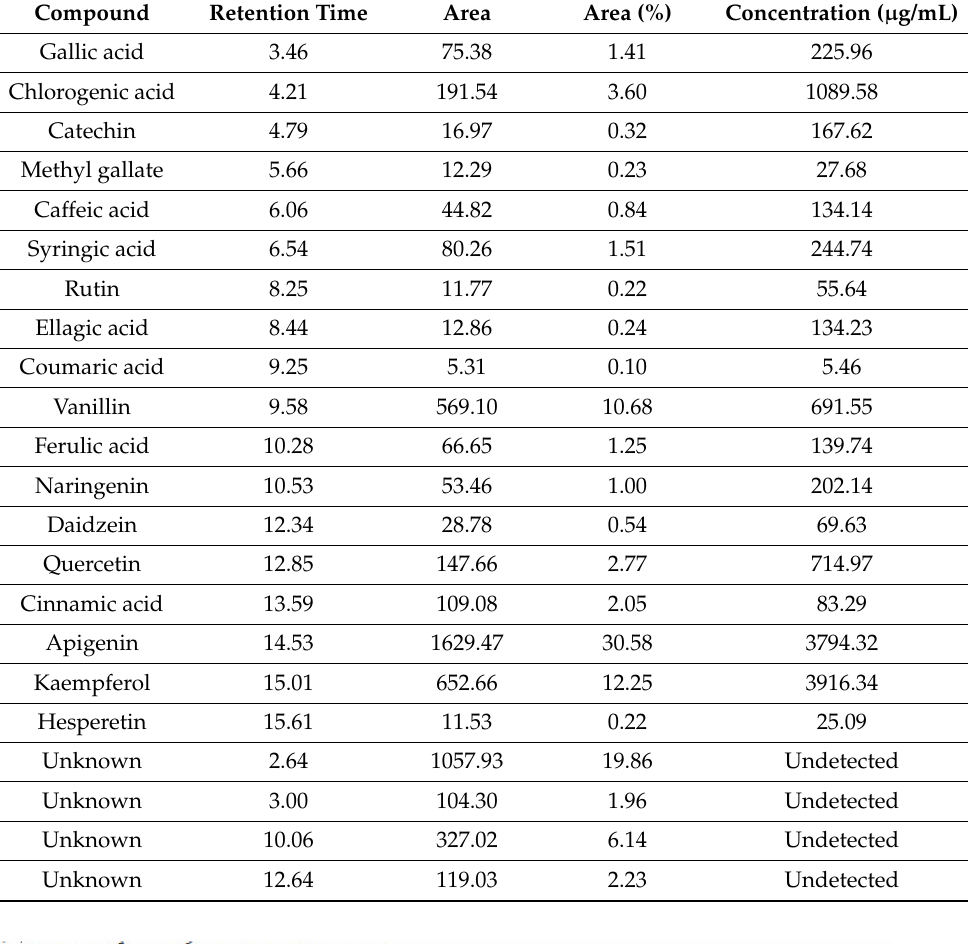
Table 1. Polyphenolic and flavonoid compounds detected in Artemisia judaica extract.